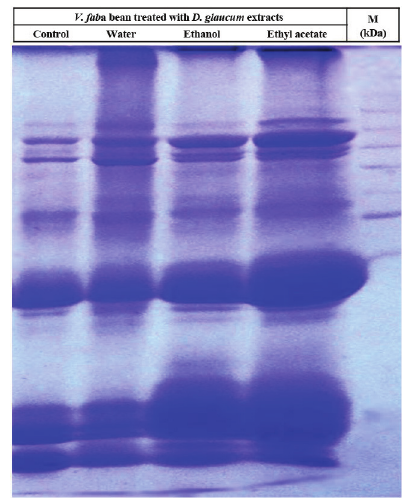
Figure 3 - SDS-PAGE protein patterns of V. faba leaves treated with different D.